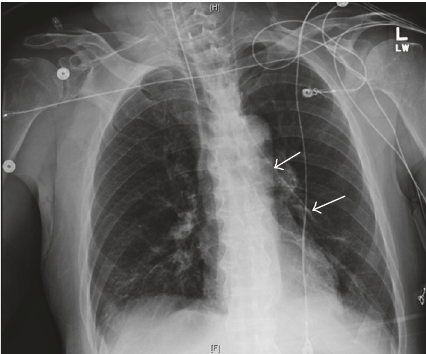
Figure 1: Inspiratory chest X-ray showing left internal jugular central catheter in aberrant left superior pulmonary vein (arrows).